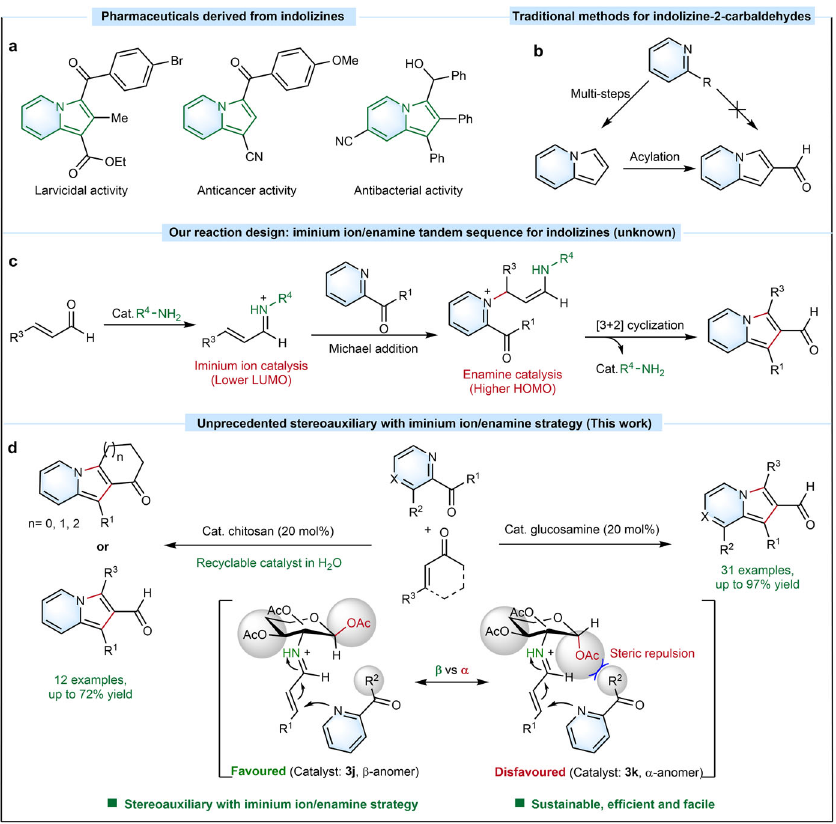
Fig. 1 Indolizine. a Pharmaceuticals derived from indolizine. b Traditional approaches for indolizine-carbaldehydes. c Our design: iminium ion/enamine tandem sequence strategy for trisubstituted indolizine-2-carbaldehydes. d This work: Unprecedented stereoauxiliary aminocatalysis with iminium ion/enamine strategy for the preparation of 1,2,3-trisubstituted indolizine-2-carbaldehydes via one-pot